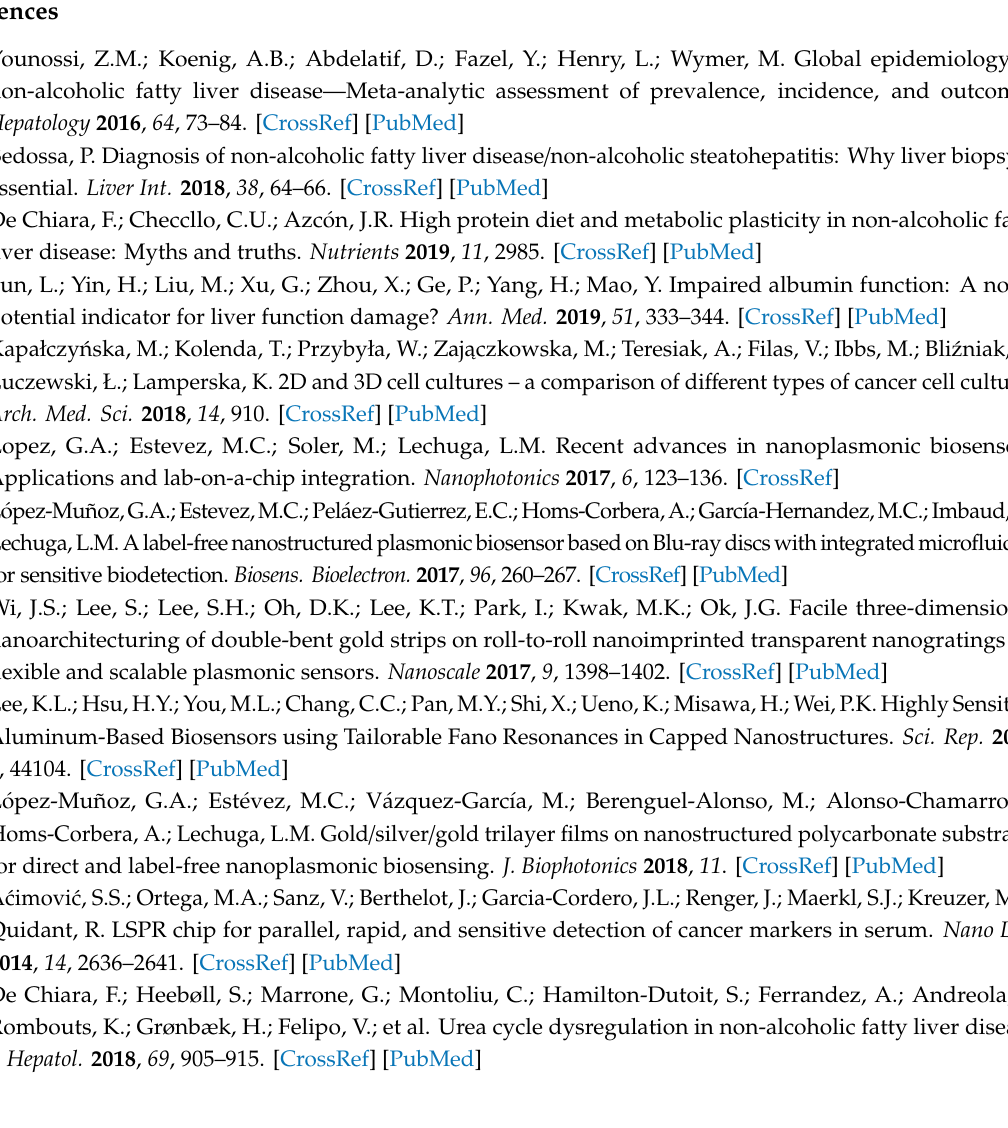
Figure S1: Calibration curves using 0 and 10%